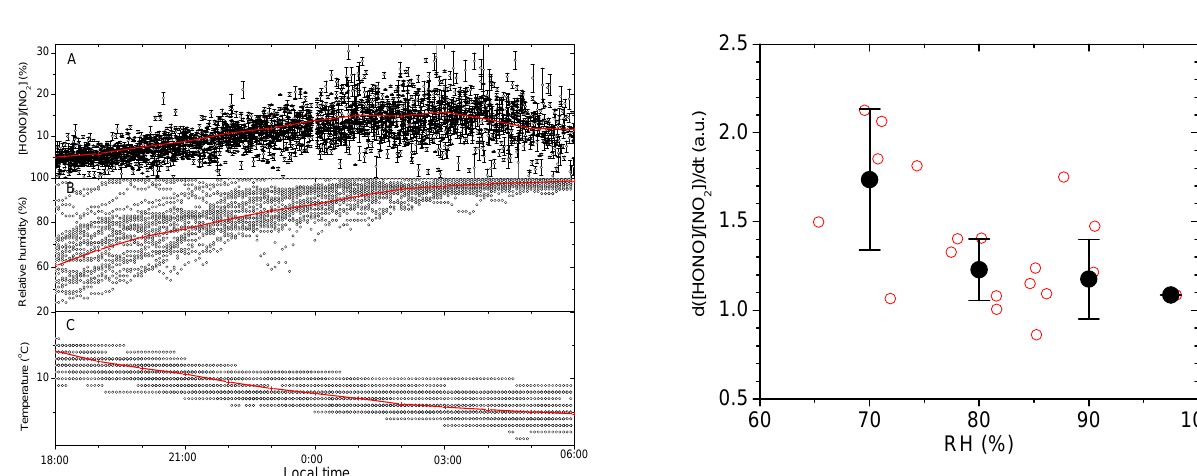
Figure 6. [HONO] / [NO 2 ], relative humidity, and temperature in the nocturnal Kathmandu atmosphere during the whole observation period. Lines with plus marks show average values.